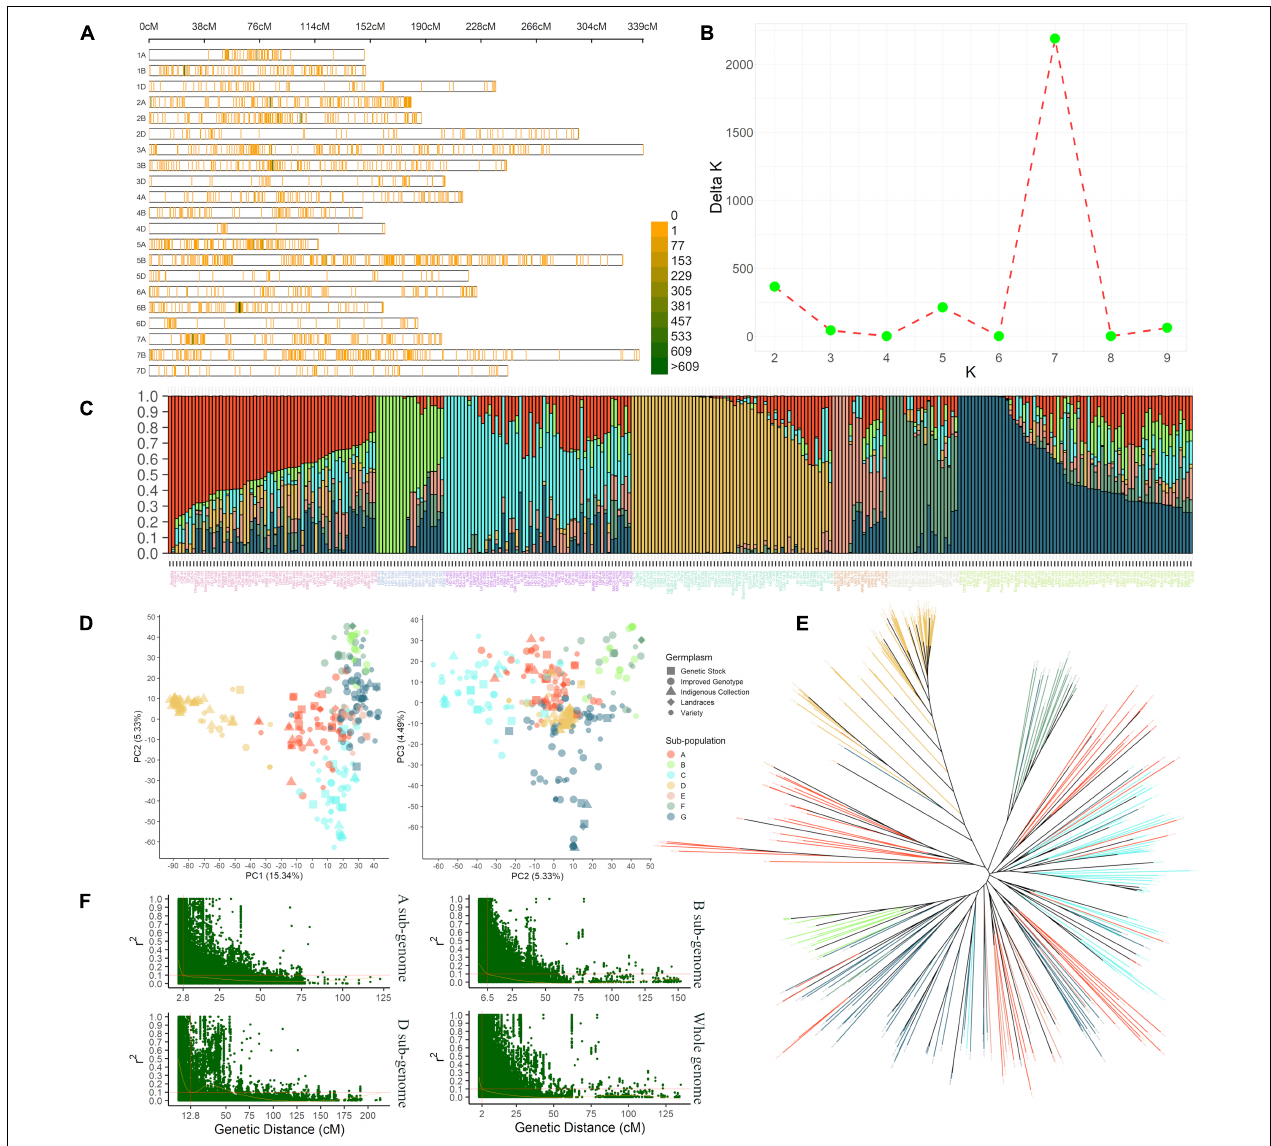
FIGURE 2 | The density plot (A) shows the SNPs’ chromosome-wise distribution pattern with a 1 Mbp window in present IWAMP. The line graph (B) indicates the best K value estimated by the method described in Evanno et al. (2005) to identify the optimum number of sub-populations in the present AMP. The bar plot (C) summarizes the genetic composition of AMP; followed to this are PCA plots (D) and NJ cladogram (E) , which show a nearly similar pattern for population stratification. Finally, the scatter plots (F) show the genetic distance at which LD decayed for sub-genomes (A,B,D) and the whole